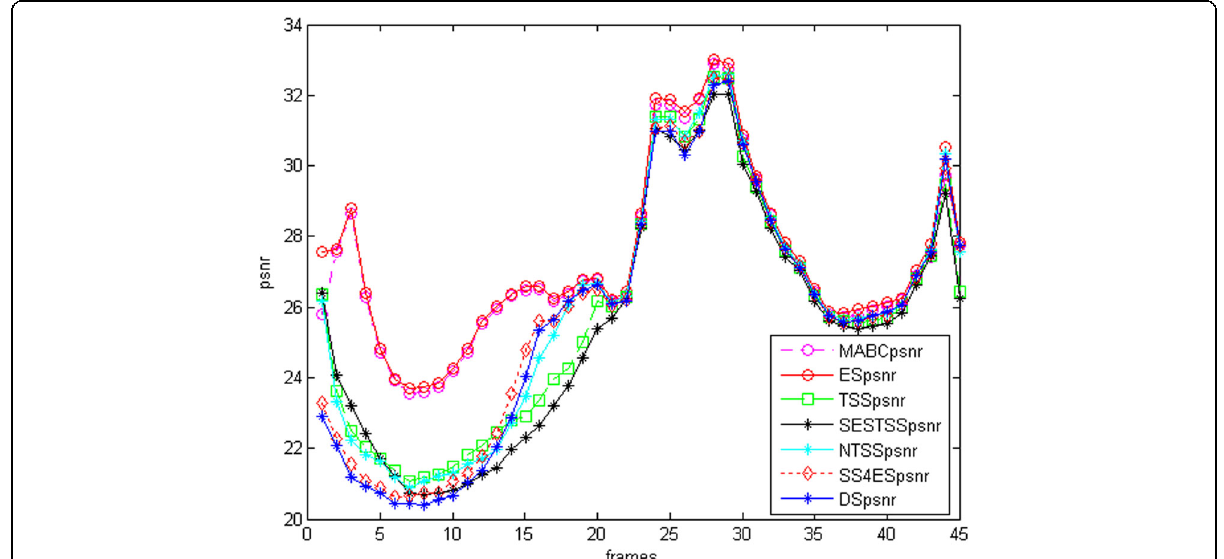
Fig. 6 Comparison of the PSNR values of the 45 frames of “ Stefan.cif ”